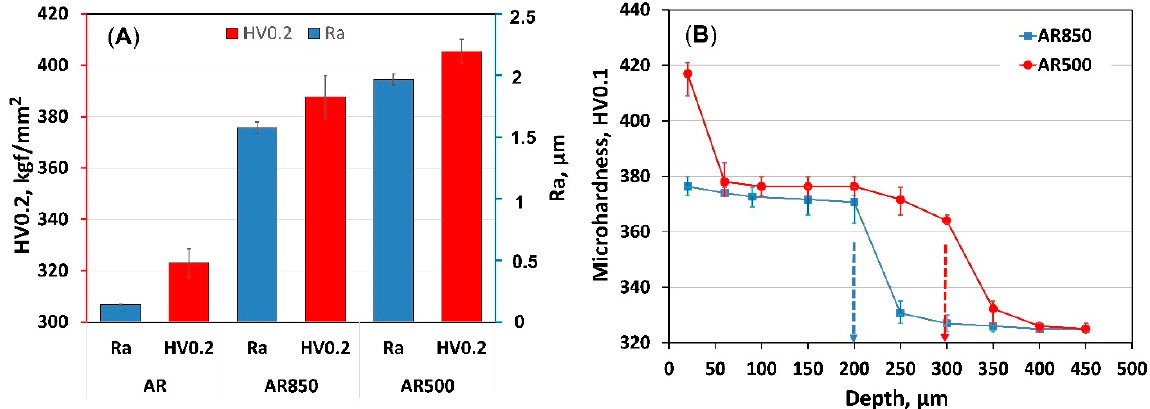
Figure 2. Comparison of ( A ) roughness values and surface hardness, and ( B ) cross-section hardness of EBM substrate material.